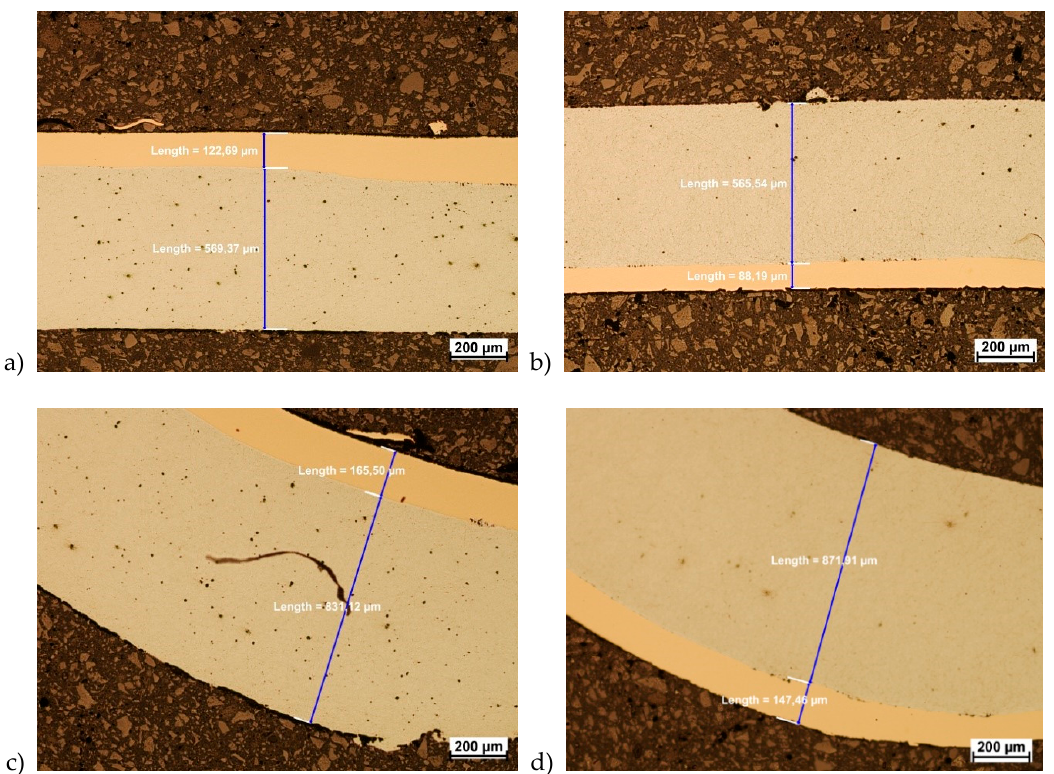
Figure 9. Welding area after the last drawing process. ( a ) side-wall area matrix–aluminum variant; ( b ) side-wall area matrix–copper variant; ( c ) matrix–aluminum variant in the sample rounding, ( d ) matrix–copper variant in the sample rounding.